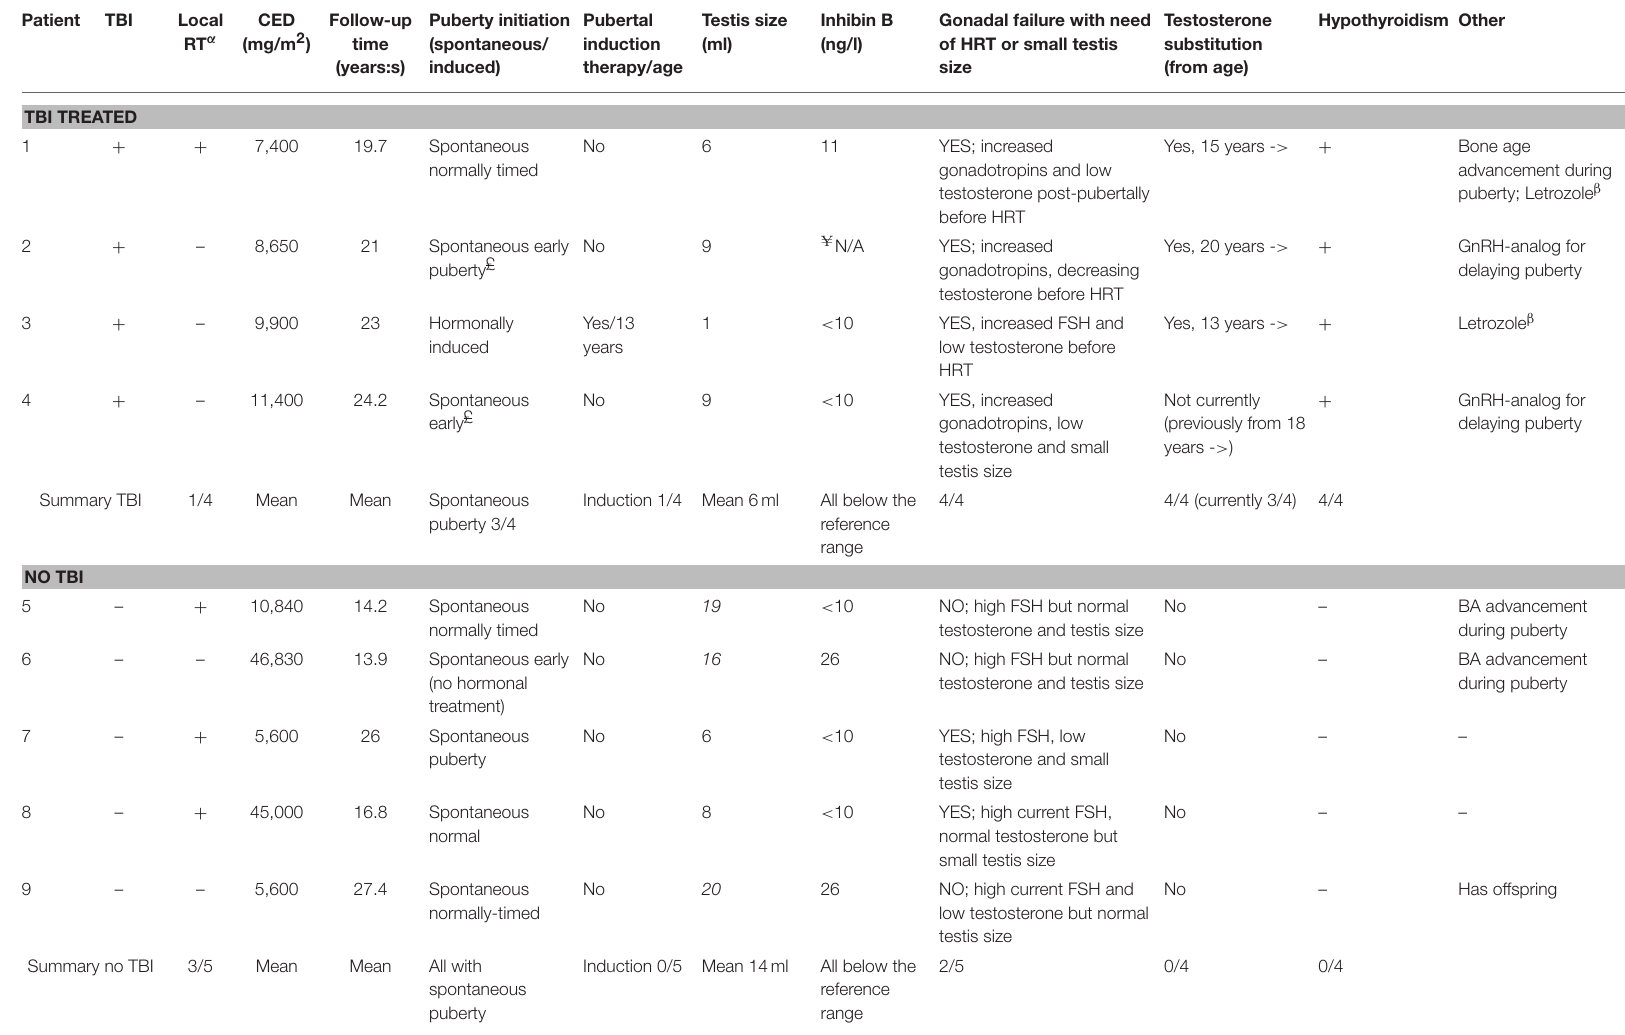
TABLE 2 | Pubertal development, need of hormone substitution and cumulative alkylating chemotherapy in male survivors ( n = 9) of childhood high-risk neuroblastoma. Patient